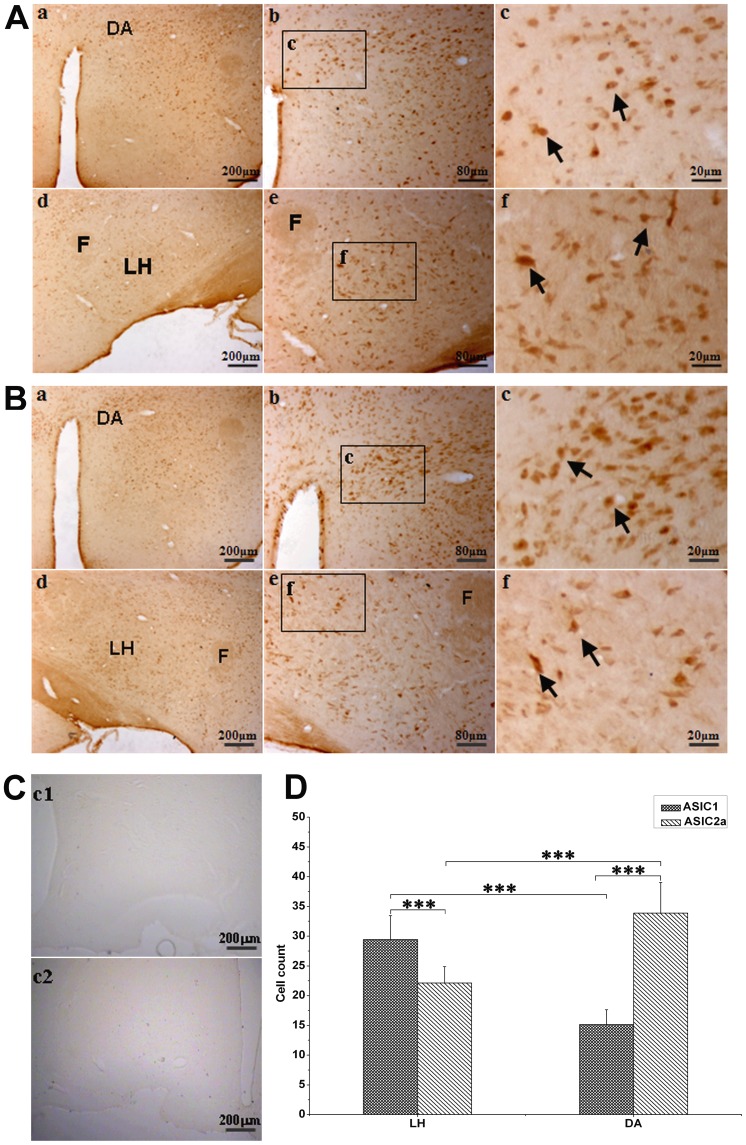
Distribution of ASIC1-ir and ASIC2a-ir neurons in the hypothalamus.A: ASIC1-ir neurons in the dorsal hypothalamus area (DA) (a, b, c) and in the lateral hypothalamus (LH) (d, e, f). B: ASIC2a-ir neurons in the DA (a, b, c) and the LH (d, e, f). C: c1∶1% BSA controls; c2: The peptides absorbed antibody control. D: Group data show the numbers of ASIC1- and ASIC2a-positive cells per visual field under microscope (×200) in the LH and DA. (*** P<0.001, n = 6).